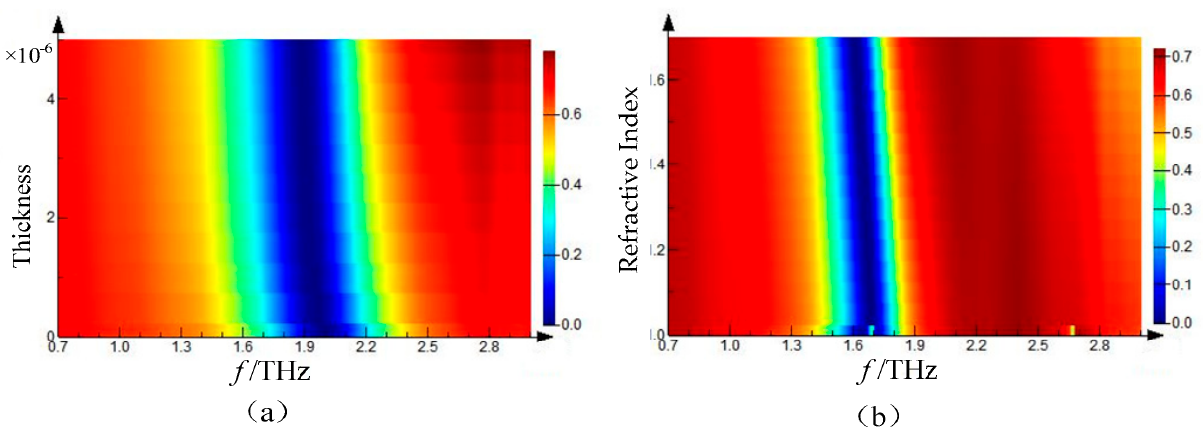
Figure 5. ( a ) Variation of transmission spectrum with the thickness of the coating—the thickness of the coating is fixed at